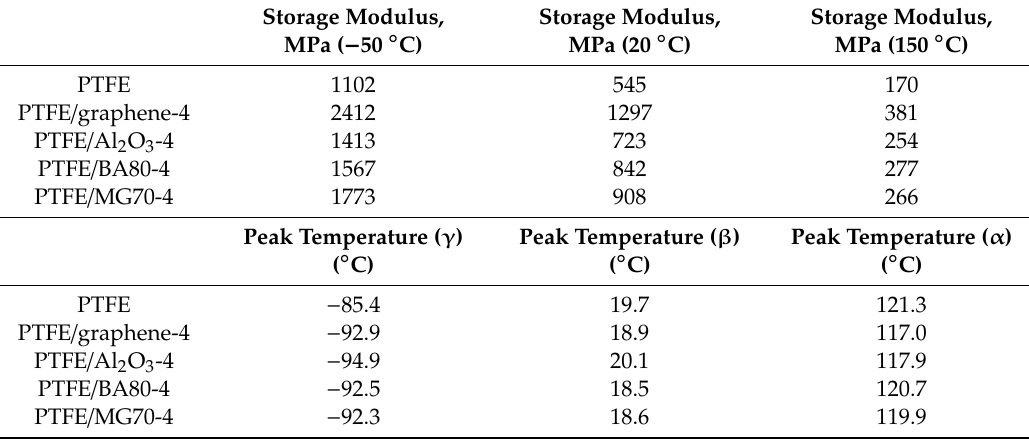
Figure 6. DMA characterisation of neat PTFE and 4 wt % filled PTFE samples. Table 3. DMA analysis of sintered filled / unfilled PTFE